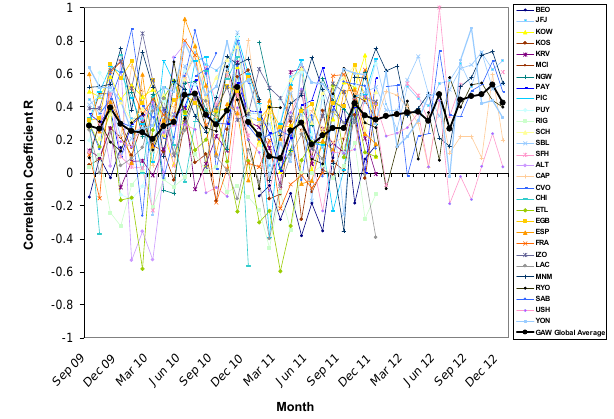
Figure 12. Correlation coefficient ( R ), derived from the evaluation of the MACC_osuite with GAW CO surface observations over the period September 2009 to December 2012 (black line: global av- erage of 29 GAW stations. Multi-coloured lines: individual station results; see legend to the right).